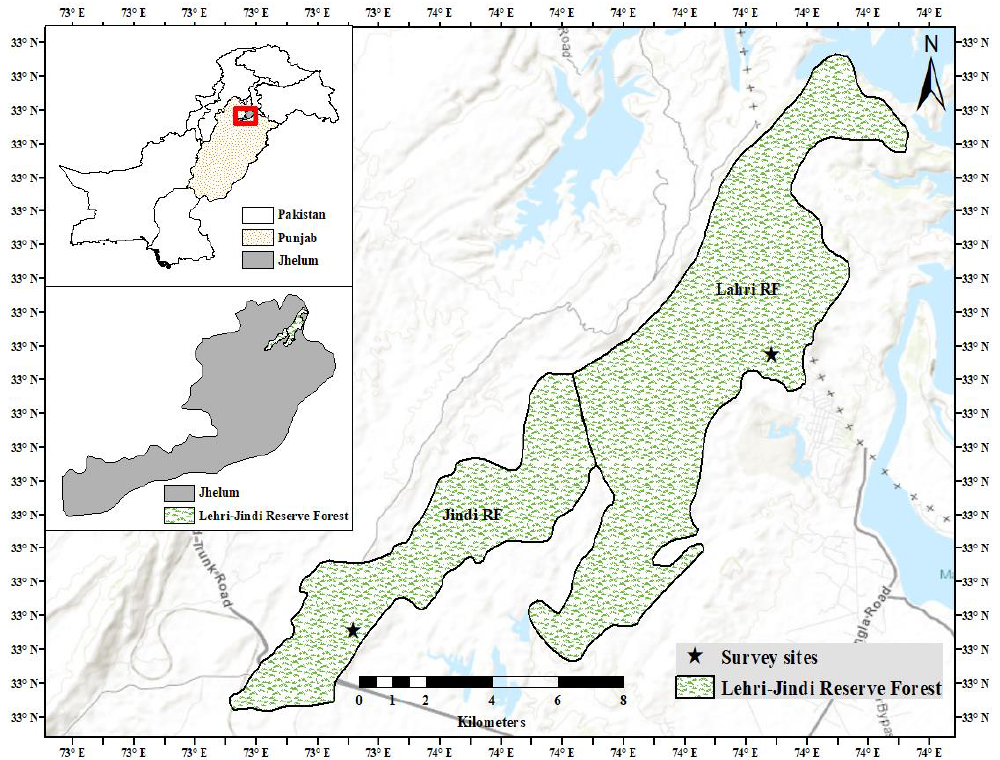
Figure 2. Map of the study area showing survey sites, located in North Jhelum in Punjab, Pakistan.